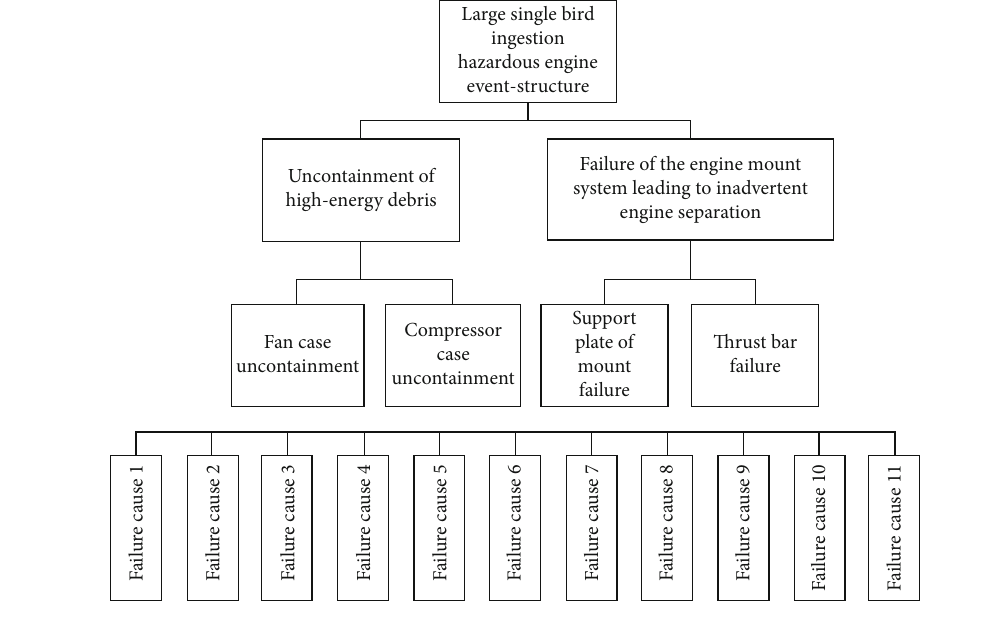
Figure 1: Fault tree analysis of bird ingestion. Table 2: Reasons of